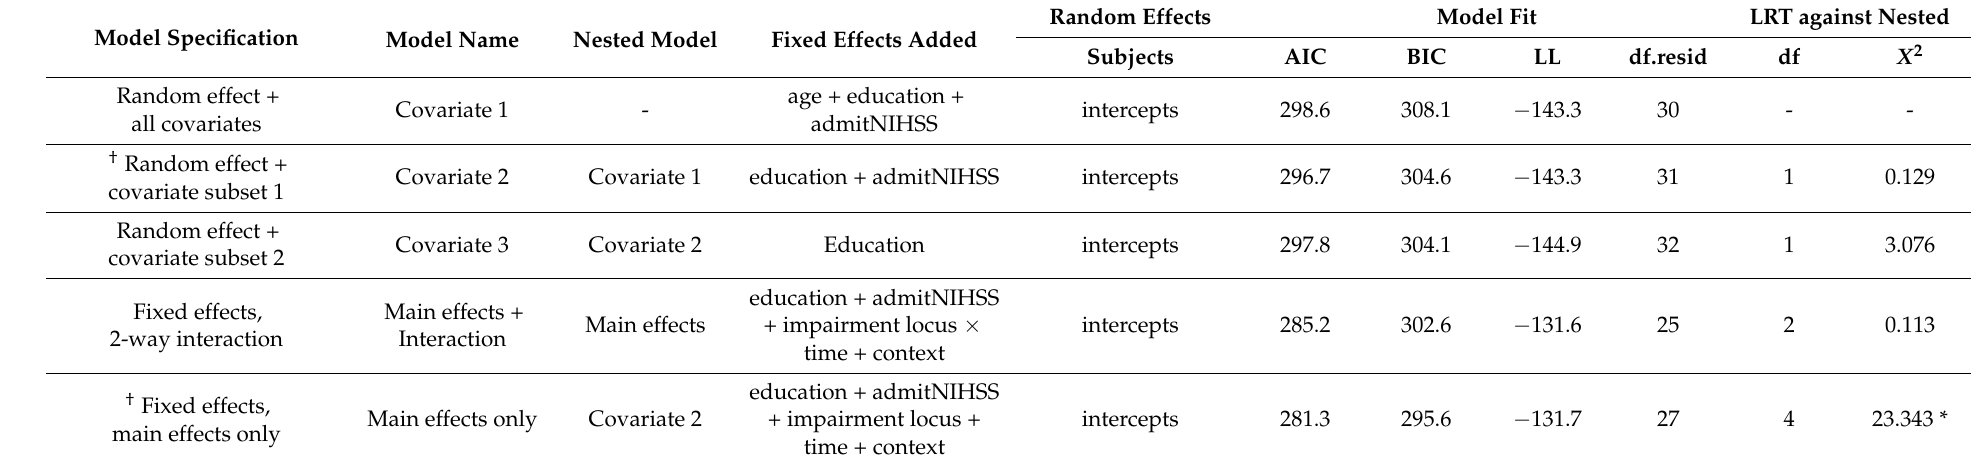
Table 2. Summary of base and full model-selection